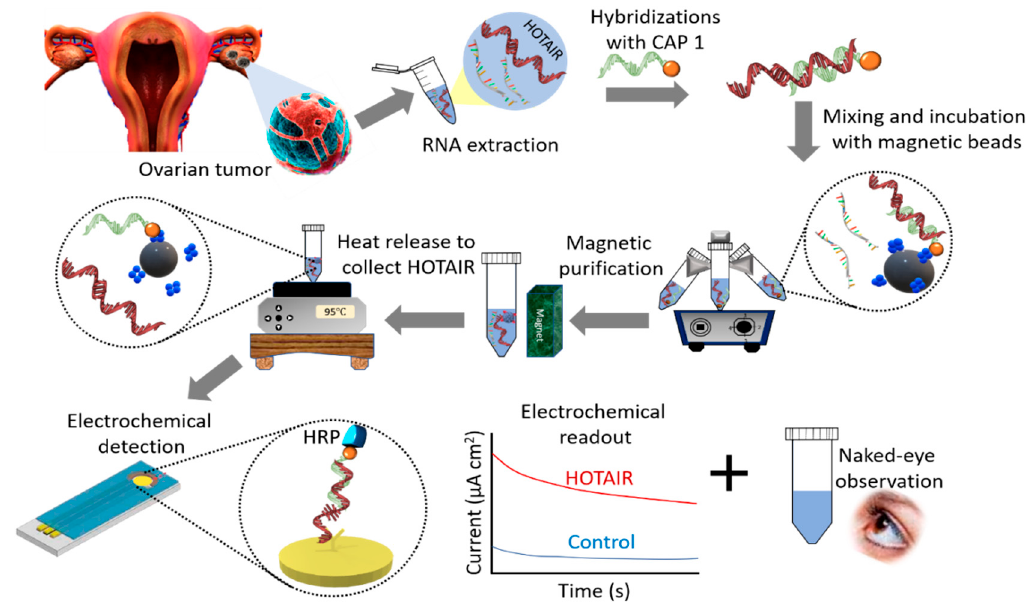
Figure 1. Schematic representation of the amplification free colorimetric detection of lncRNA. Magnetically captured target lncRNAs (top, right) were heat released and adsorbed on a thiolated-DNA modified screen-printed gold electrode (bottom). The relative presence of lncRNA is analyzed by HRP-catalyzed colorimetric reaction in the presence of 3,3 ′ ,5,5 ′ -tetramethylbenzidine (TMB)/H 2 O 2 system.